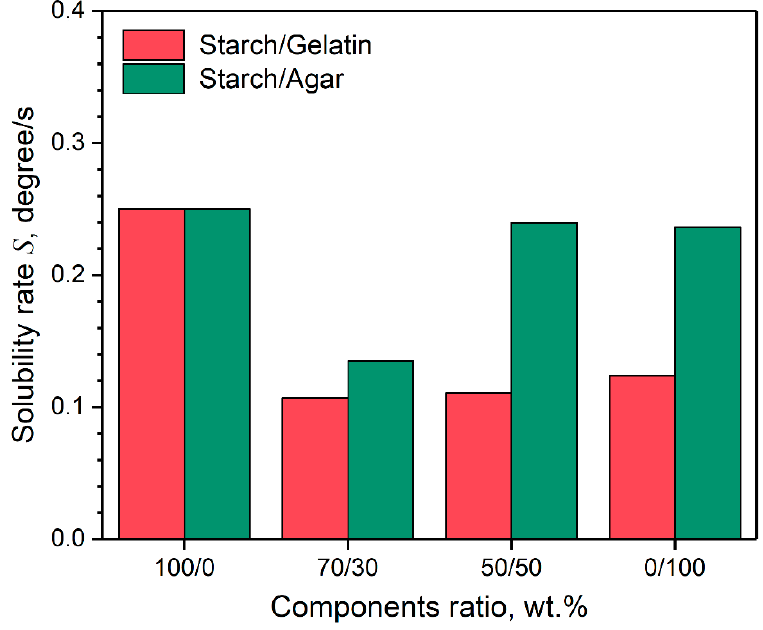
Figure 8. Solubility rate of the coatings depends on their composition.